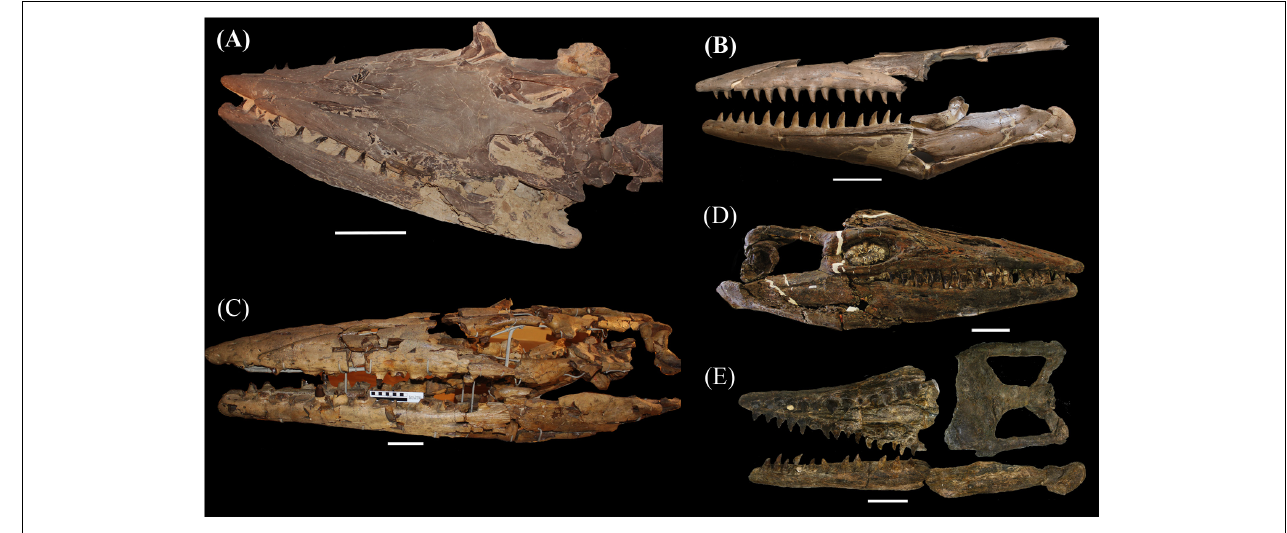
FIGURE 4 | Specimens assigned to the genus Tylosaurus . (A) T. proriger KU 66129; (B) T. nepaeolicus AMNH 124, 134; (C) T. bernardi IRScNB 3672; (D) T. saskatchewanensis (holotype) RSM P2588.1; (E) T. pembinensis MMV 95 2. All scale bars equal to 100